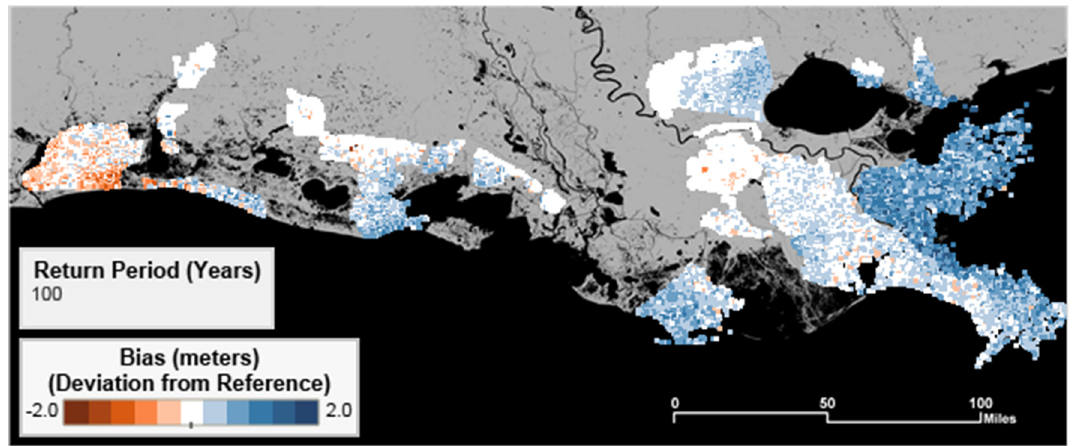
Figure 1. Deviation from reference set in 100 ‐ year flood depth exceedances in screening analysis watersheds from a suite consisting of 90 storms (screening set S3).